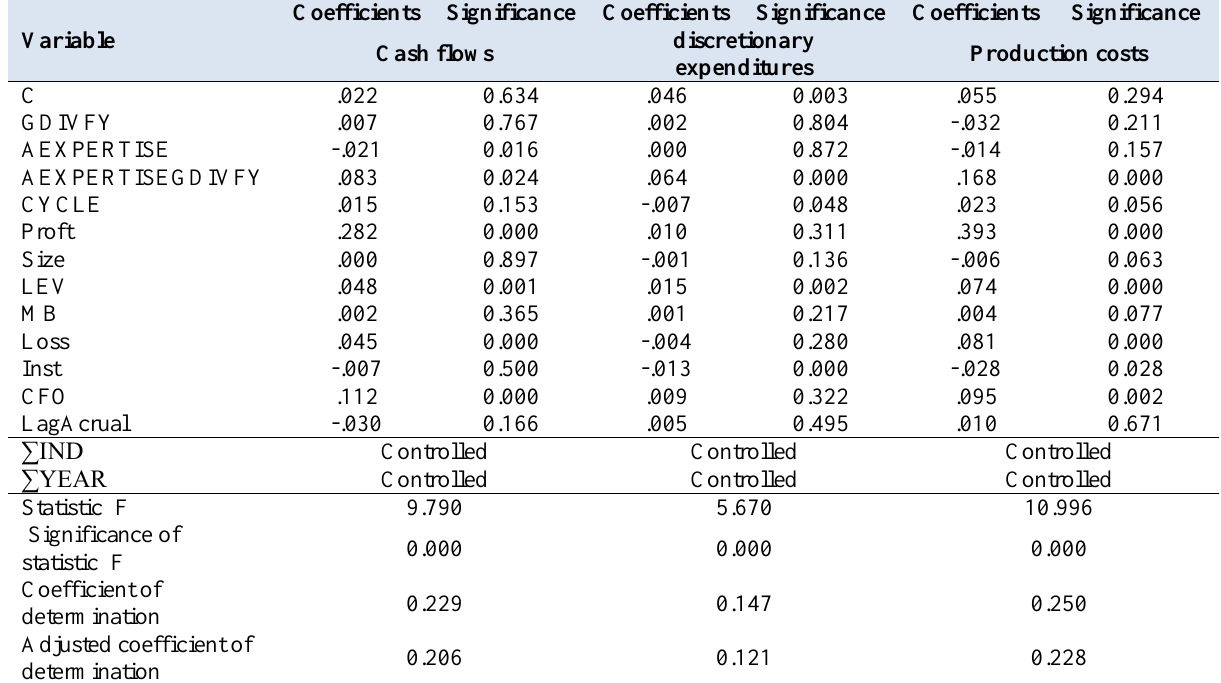
Table 5. Test Results of the Second Research Hypothesis (Dependent Variable; Real Earnings Management, Independent Variable; Industry-Expertise